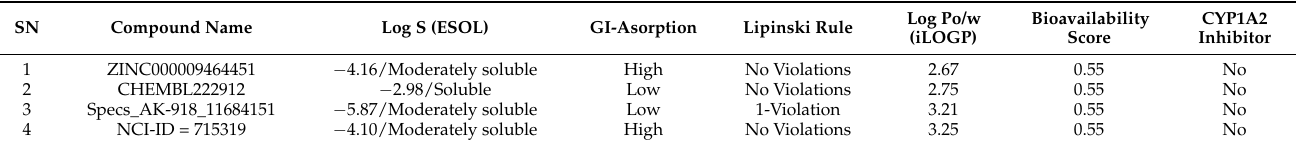
Table 8. ADMET and drug-likness profile of the identified